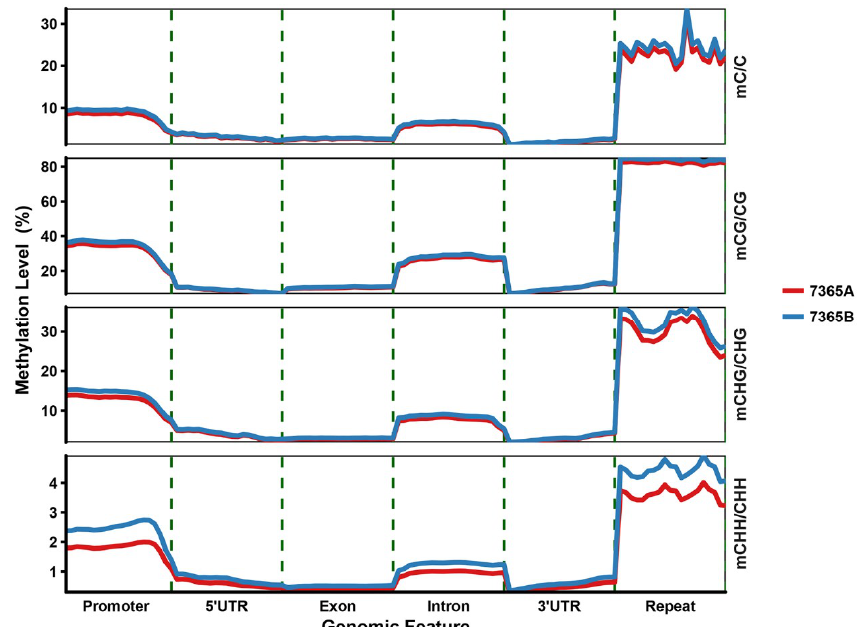
Figure 4. Average density of DNA methylation in different genomic functional regions in 7365A and 7365B. Each functional region was equally divided into 20 bins, and the mean density of the methylated cytosines was defined as the methylation density in each bin.